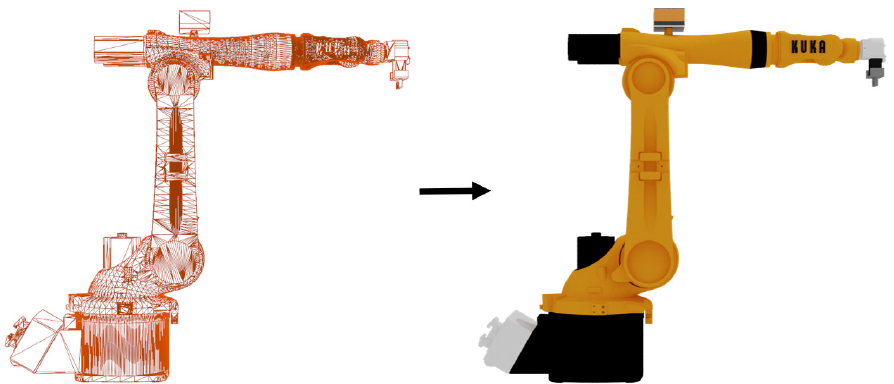
Figure 3. The designed and optimized KUKA KR5 3D model.